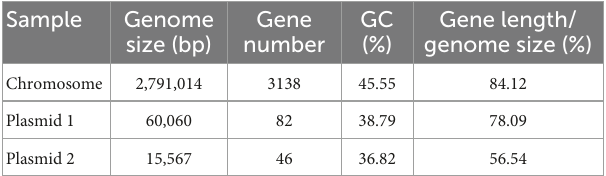
TABLE 2 Assembly statistics of the Lp. plantarum MC5